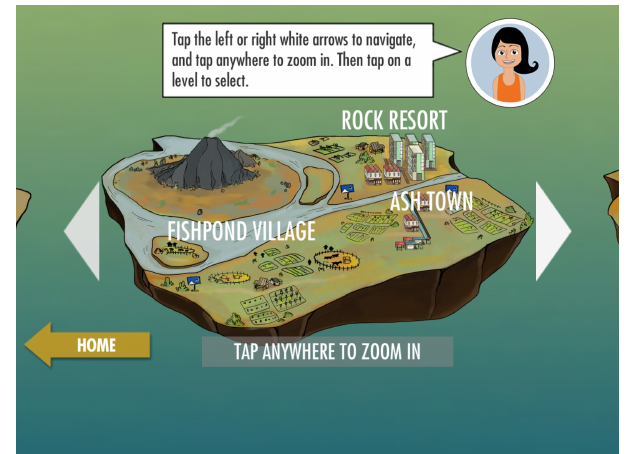
Figure 5. The navigation map displays nine different locations where the action can take